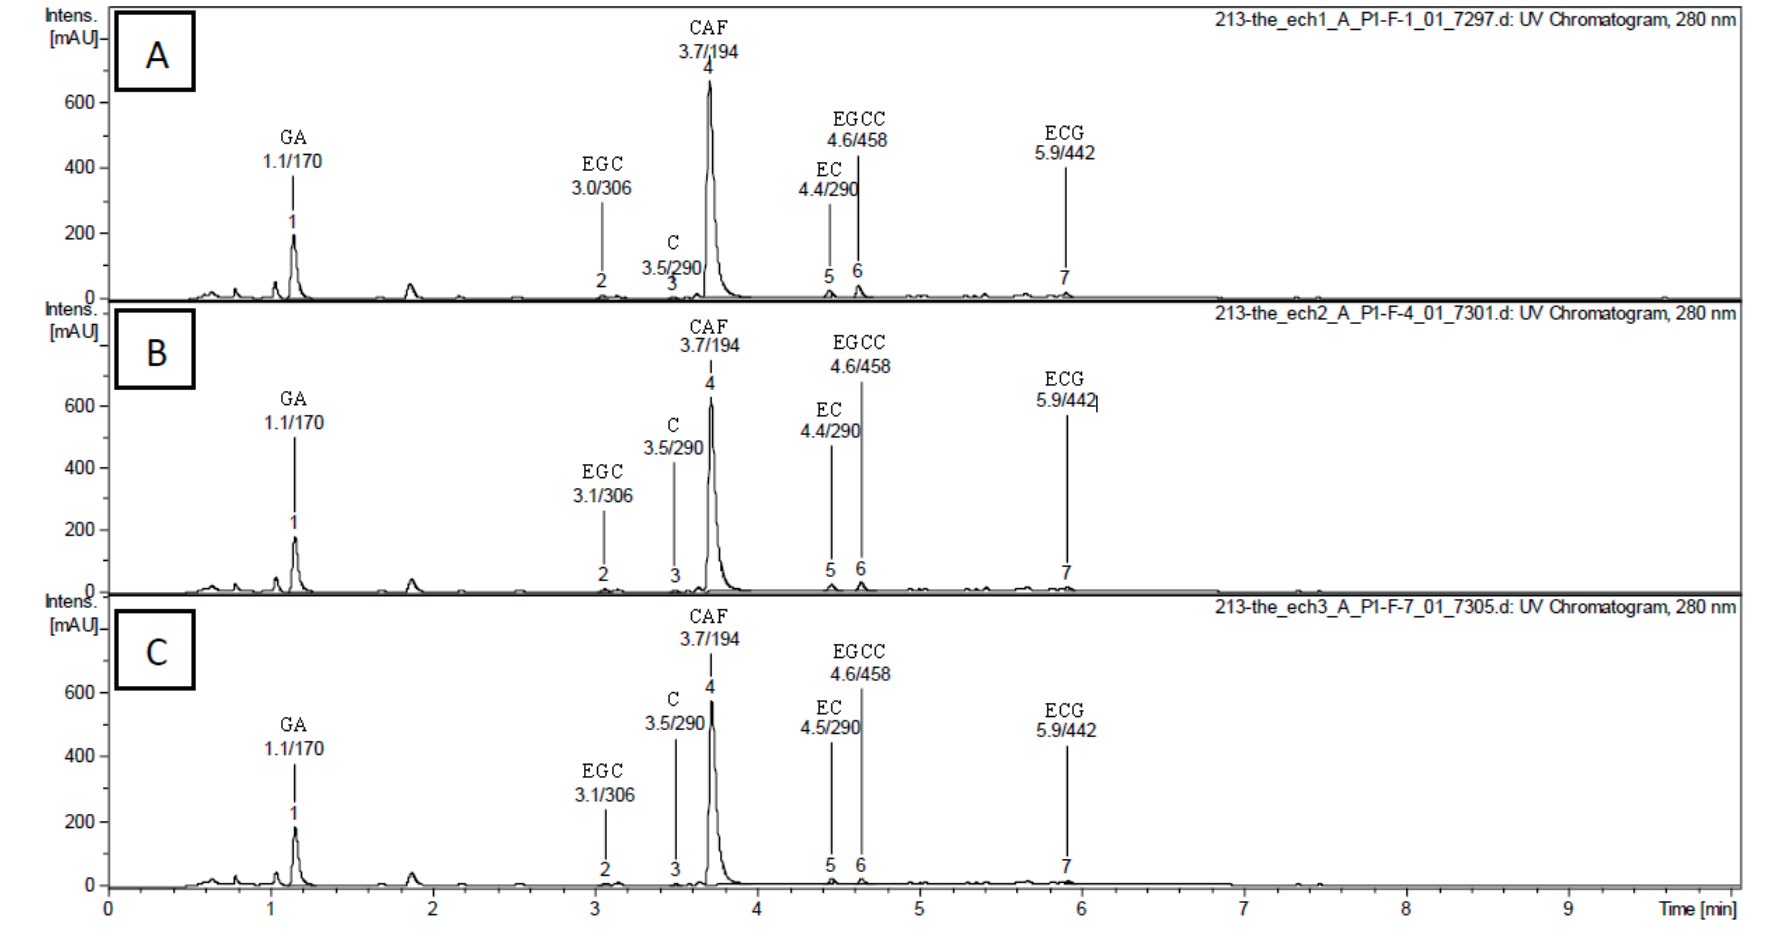
Figure 1. HPLC-DAD/ESI-MS chromatogram of tea extracts ATE-5 ( A ), ATE-15 ( B ) and ATE-30 ( C ) at 280 nm (retention time/molecular weight). The numbered peaks are denoted in Table